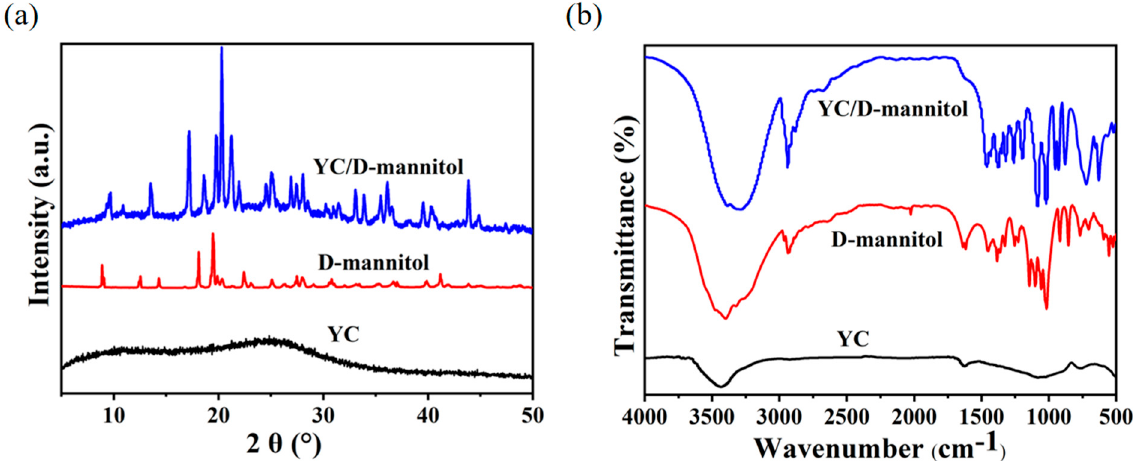
Figure 4. ( a ) XRD pa tt ern, ( b ) FTIR spectrum of YC, D-mannitol, YC/D-mannitol.